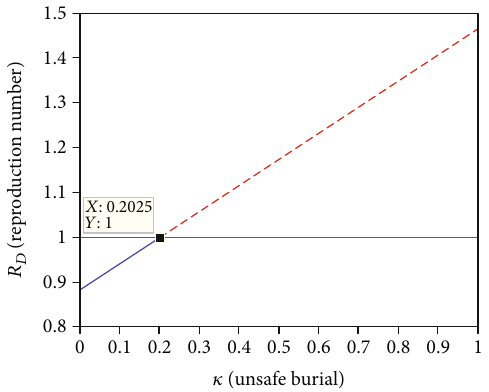
Figure 2: Graph of reproduction number R Other parameter values are given in Table